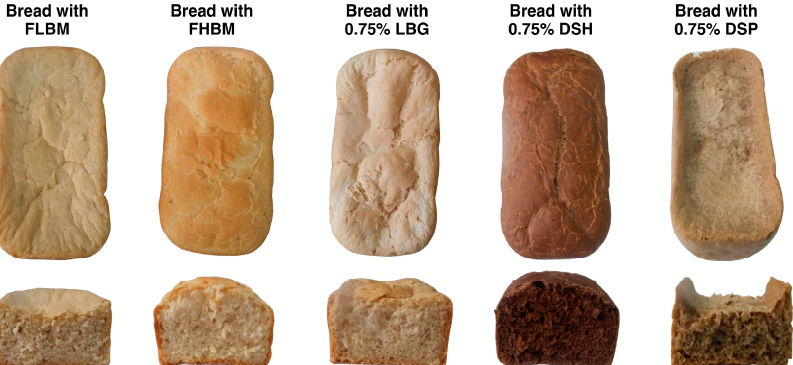
Figure 4. Bread photos (front view and cross-section) prepared with FLBM, FHBM, FLBM supplemented with 0.75% LBG, FLBM supplemented with 0.75% DSH from the Allig variety, FLBM supplemented with 0.75% DSP from the Allig variety. FLBM, flour of low bread-making quality; FHBM, flour of high bread-making quality; LBG, locust bean gum; DSH, date seed hemicellulose; DSP, date seed polysaccharides.